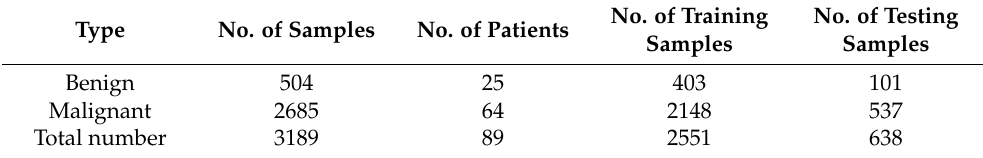
Table 2. The Demographic